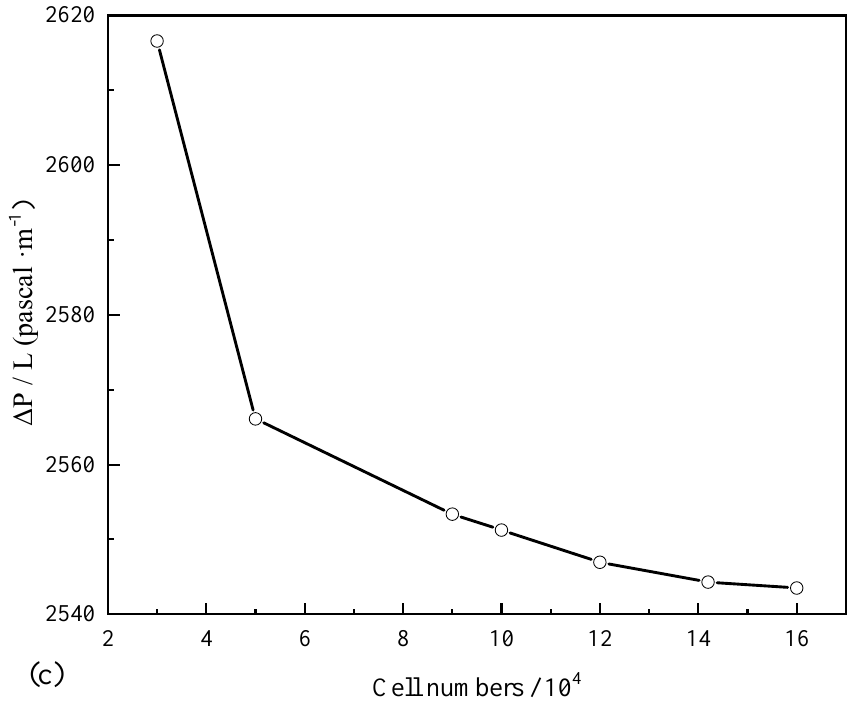
Figure 3. Comparison of ( a ) solid-phase velocity distribution ( b ) IVF distribution ( c ) pressure drop at different grid densities.